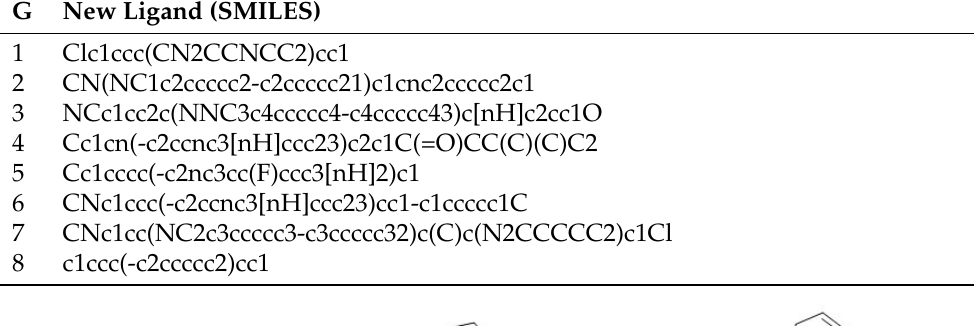
Table 8. New ligands with best binding energy using the heuristic search approach.